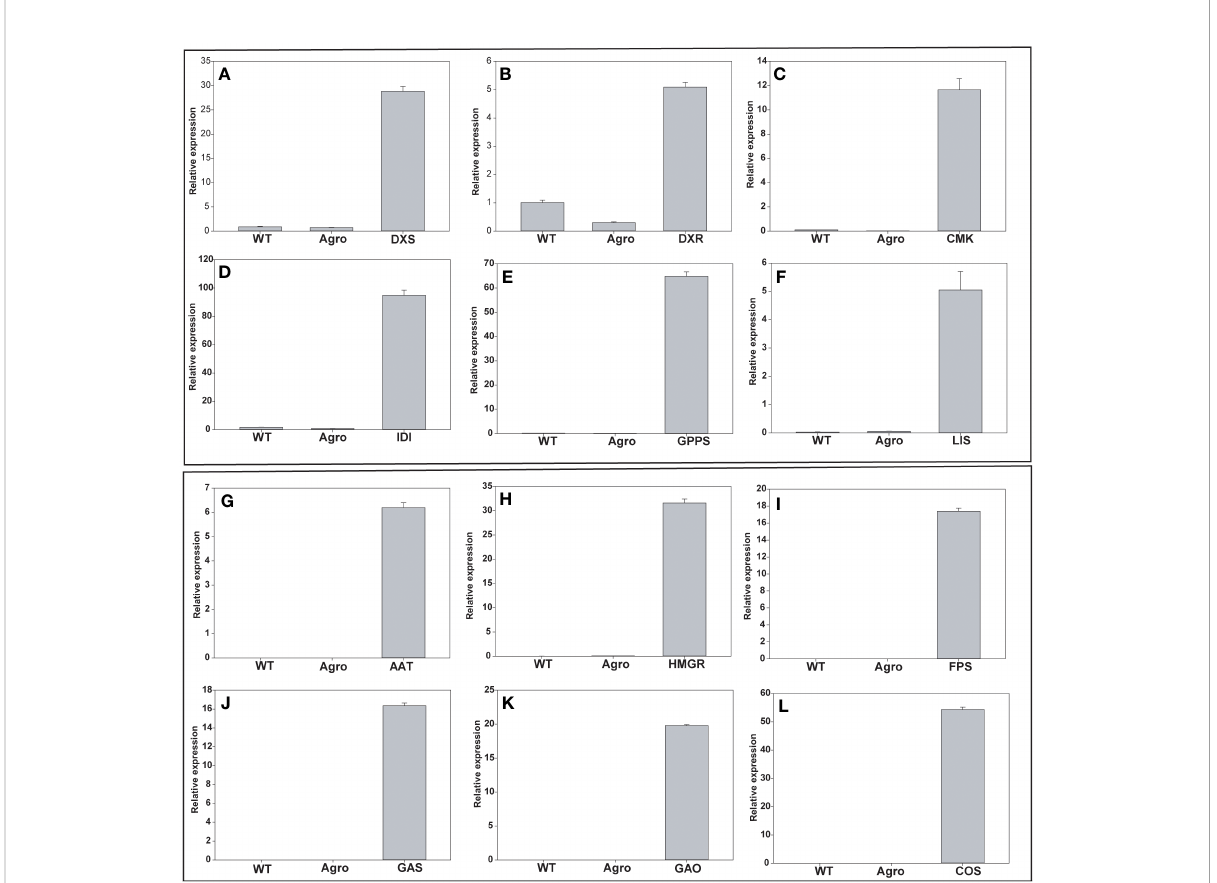
FIGURE 3 mRNA overexpression analysis of MEP and MVA pathway genes using qRT-PCR. (A) DXS, (B) DXR, (C) CMK, (D) IDI, (E) GPPS (F) LIS, (G) AAT, (H) HMGR, (I) FPS, (J) GAS, (K) GAO, and (L) COS. Gene expression levels were normalized to those of PP2A and their relative expression is shown. MEP, plastid 2-C-methyl-D-erythritol 4-phosphate; MVA, mevalonate; DXS, 1-deoxy-D-xylulose-5-phosphate synthase; DXR, 1-deoxy-D- xylulose 5-phosphate reductoisomerase; CMK, 4-diphosphocytidyl-2-C-methyl-D-erythritol kinase; IDI, isopentenyl-diphosphate isomerase; GPPS, geranyl pyrophosphate synthase; LIS, linalool synthase; AAT, acetoacetyl-CoA thiolase; HMGR, 3-hydroxy-3-methylglutaryl-CoA reductase; FPS, farnesyl pyrophosphate synthase; GAO, germacrene A oxidase; GAS, germacrene A synthase; COS costunolide synthase; PP2A, protein phosphatase